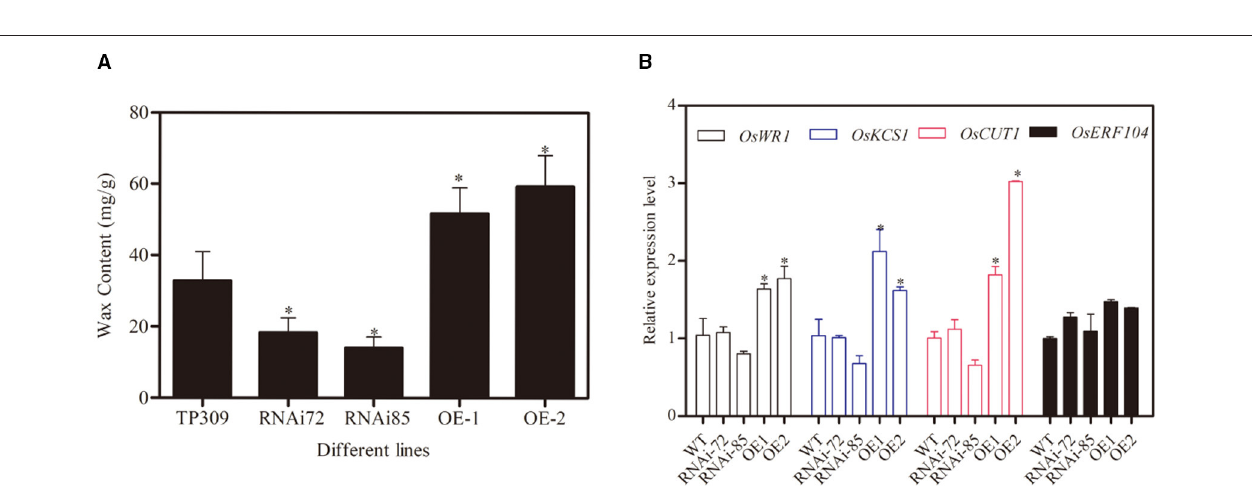
FIGURE 6 | Contents of wax and relative expression of OsWRs genes in the WT (TP309), OsNHO1 -RNAi, and OsNHO1 -OE lines. (A) Contents of wax were measured by the hot chloroform extraction method. (B) Relative expression of OsWRs genes. Each value represents the mean ± SE of three biological replicates. Asterisks indicate significant differences compared to TP309 ( p < 0.05) by one-way ANOVA followed by the Tukey’s HSD analysis. OE, overexpression; WT, wild type.